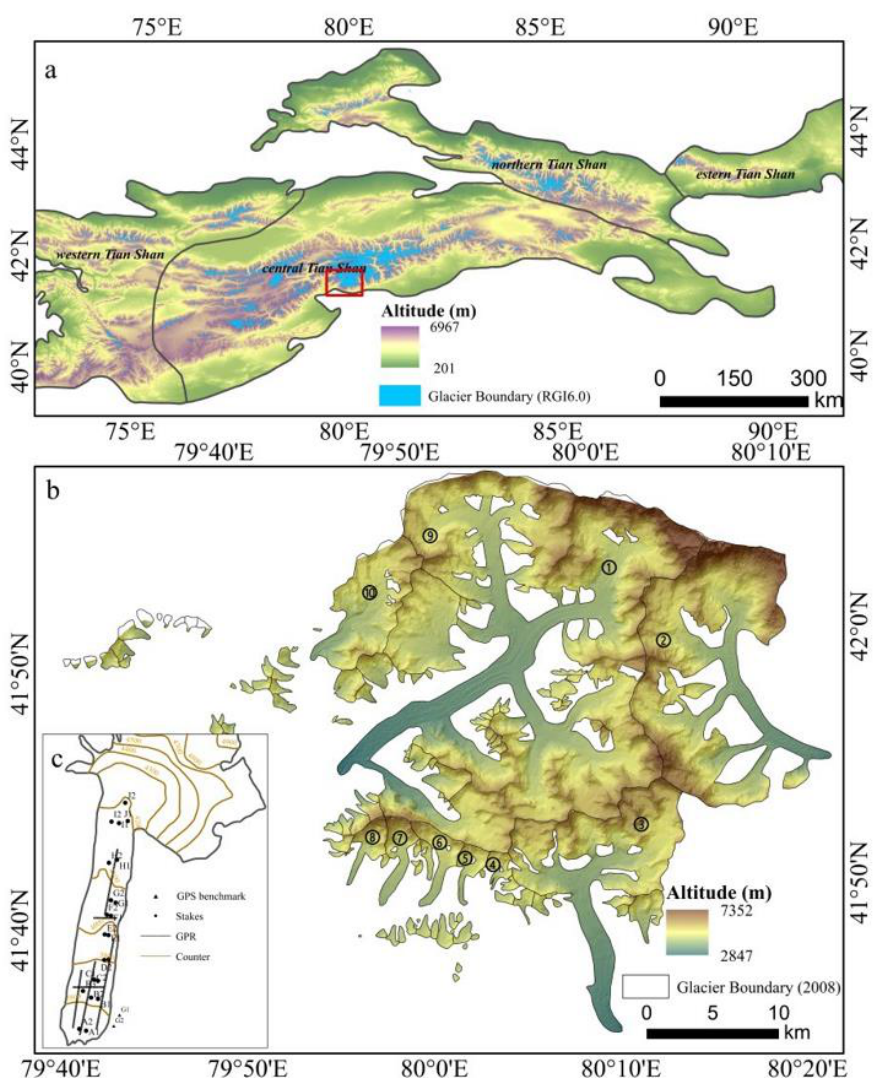
Figure 1. Geographic location of the Tomur Peak glacier, Tian Shan, China, ( a ) the regional glacier distribution, ( b ) the location of the study area in the Tian Shan Mountains, and ( c ) ( (cid:172) Tomor Glacier, (cid:173) Duntelian Glacier, (cid:174) Keqikar Glacier, (cid:175) Keke Ulong Glacier, (cid:176) Keker Glacier, (cid:177) Qiong Kurm Glacier, (cid:178) Bingtan Glacier, (cid:179) Qingbingtan Glacier No. 72, (cid:181) Ailangsu Glacier) the distribution of stakes and GPR surveys on the Qingbingtan glacier No.